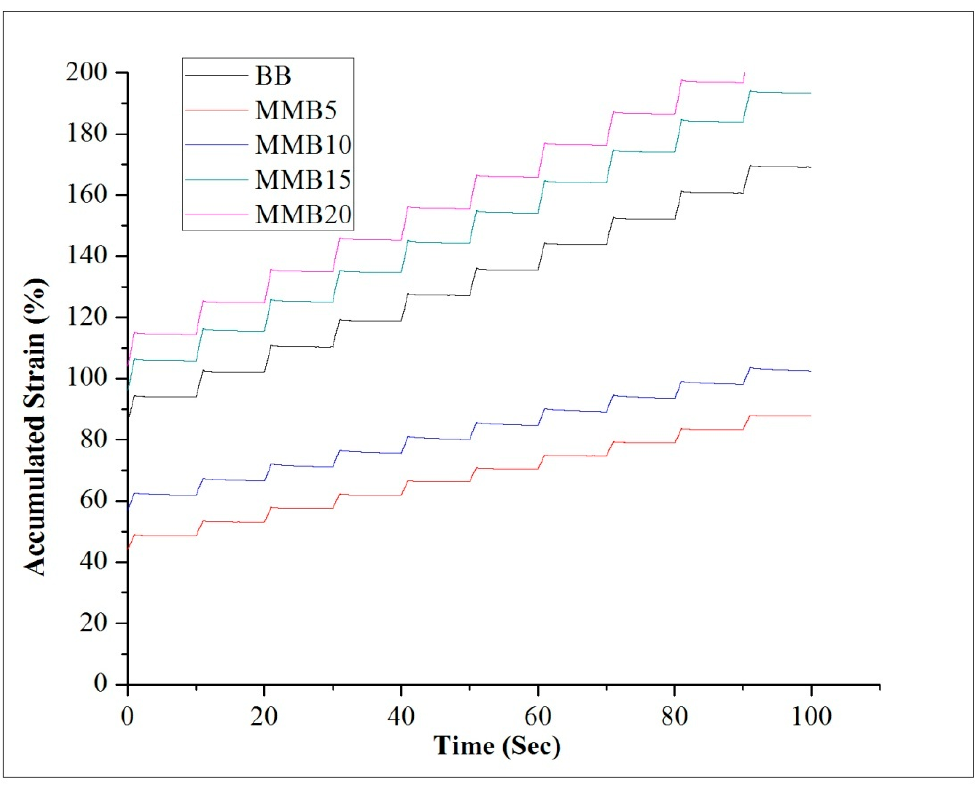
Figure 13. Cumulative total strain of binders at 0.1kPa (58°C) Appl. Sci. 2020 , 10 , x FOR PEER REVIEW